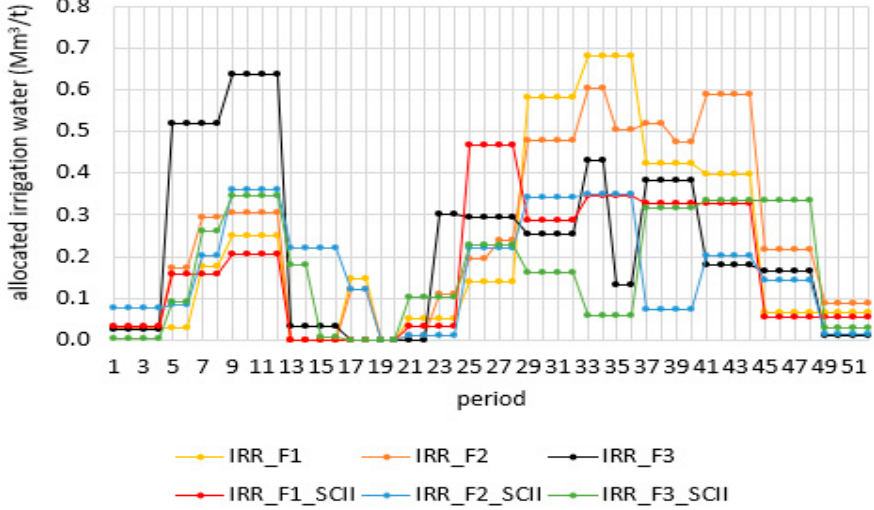
Figure 34. Comparison of irrigation water allocation between scenario II and the initial base scenario conditions (Mm 3 /week). Table 13. Comparison of optimized land allocation and attributes under different model scenario conditions.